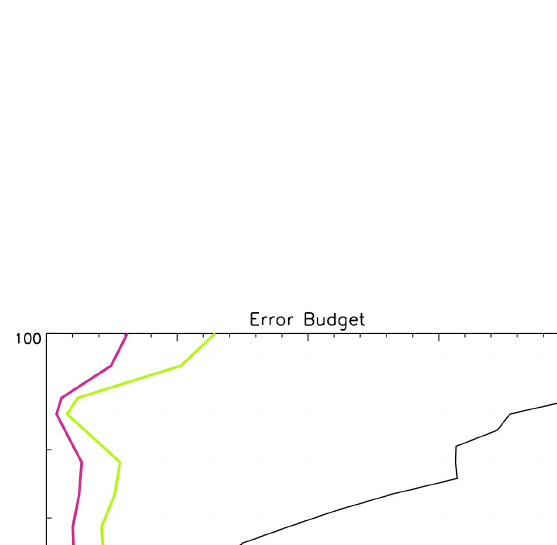
Fig. A9. Same as Fig. A4 but for 5 November 2008. Figure A9: Same as Figure A4 but for November 5 2008